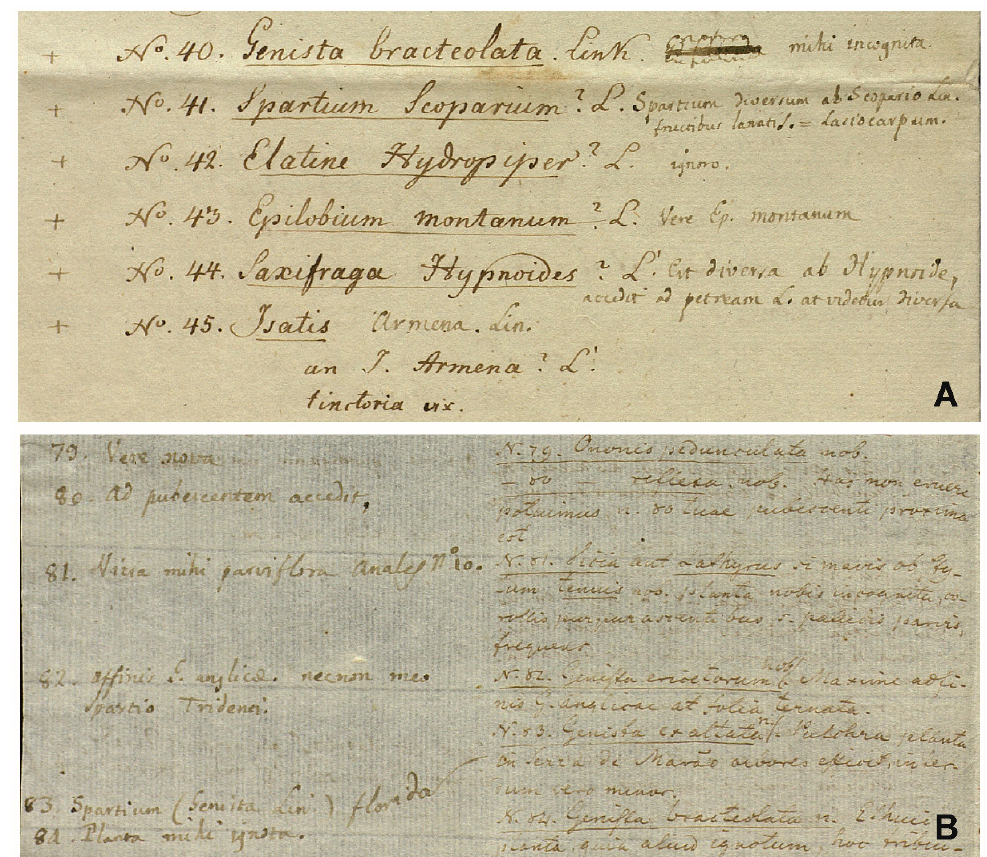
Figure 1. Letters to Cavanilles at the archive of the Real Jard í n Bot á nico of Madrid. ( A ) Fragment of the letter (page 4) sent by Hoffmannsegg [44] in April 27, 1801; original list by Hoffmannsegg (left) with the later annotations of Cavanilles (right) and the check symbol (+) near the left edge. ( B ) Fragment of the letter (page 5) sent by Link [50] in January 28, 1799; original list by Link (right) and later annotations by Cavanilles (left) with the same number.